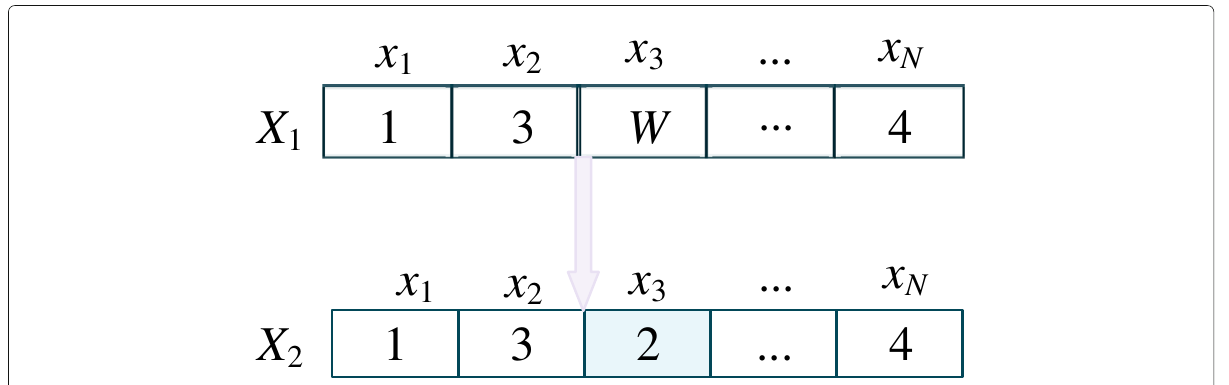
Fig. 4 An example of mutation